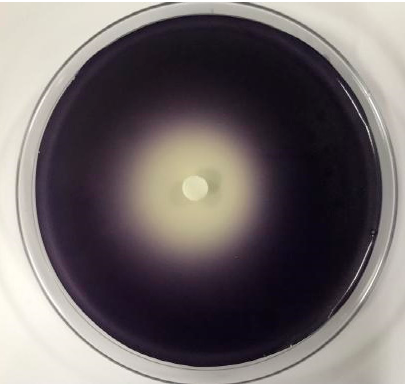
Figure 2. QSI e ff ect of C. camphora EO on biosensor Figure 2. QSI effect of C. camphora EO on biosensor CV026.